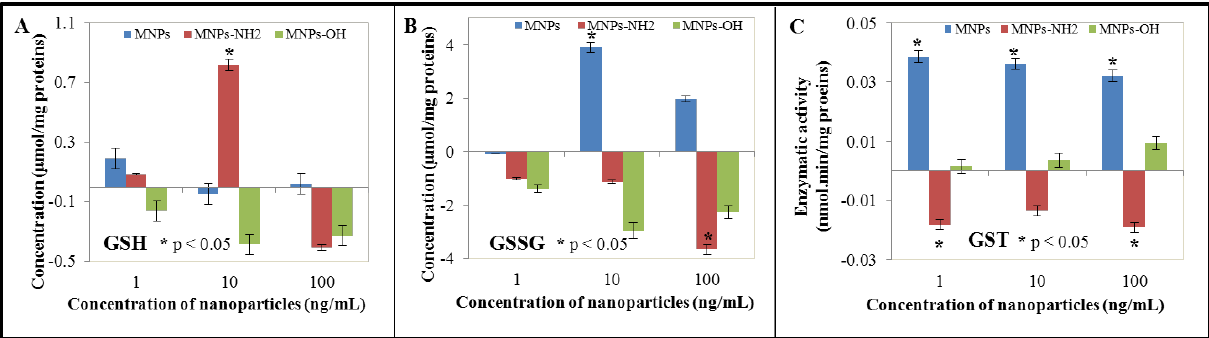
Figure 2. The influence of 0, 1, 10 and 100 ng/mL of magnetic γ-Fe (NPs) and modified magnetic nanoparticles (MNPs—Fe ( A ) concentration of reduced glutathione (GSH), ( B ) concentration of oxidized glutathione (GSSG) and ( C ) glutathione S -transferase activity (GST) of treated tobacco BY-2 cells. The results were subtracted from the control, i.e. , non-treated BY-2 tobacco cells. The cells were treated for five